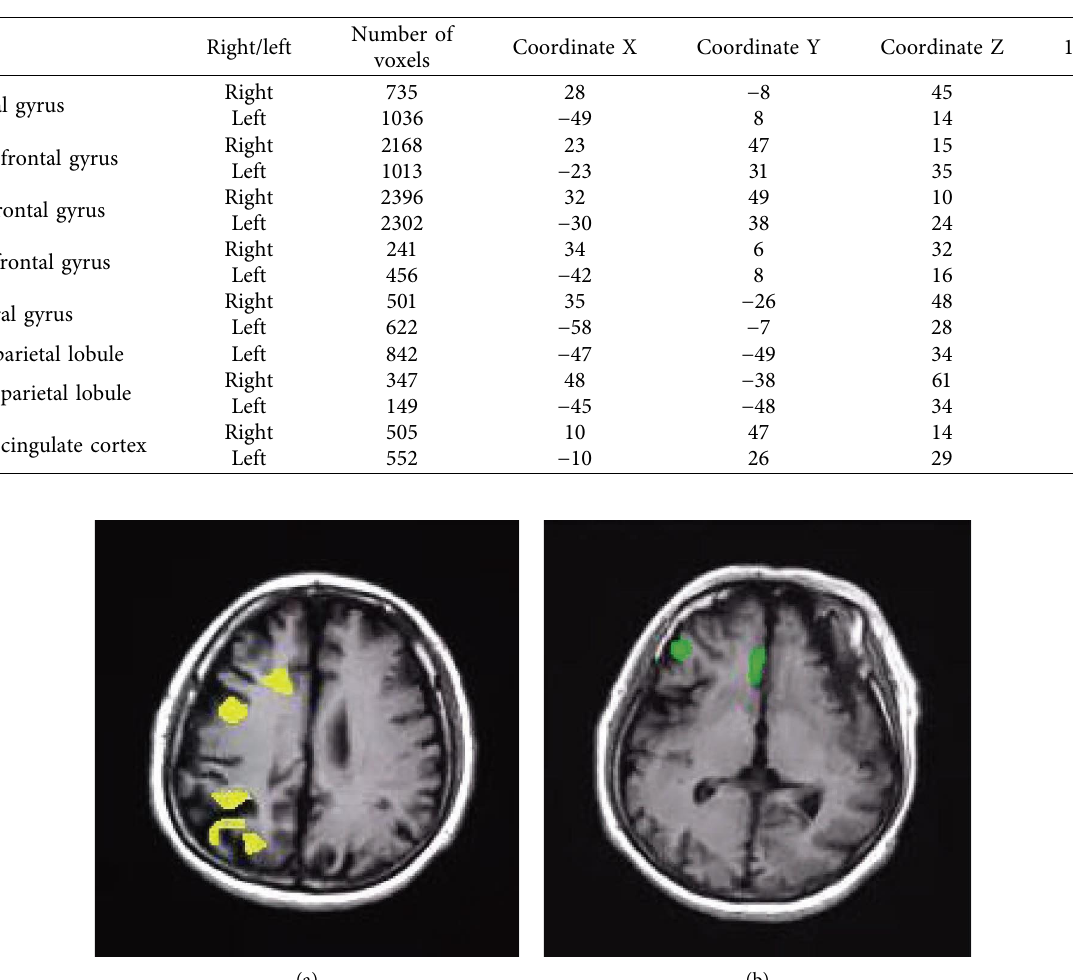
Table 2: Results of VBM.